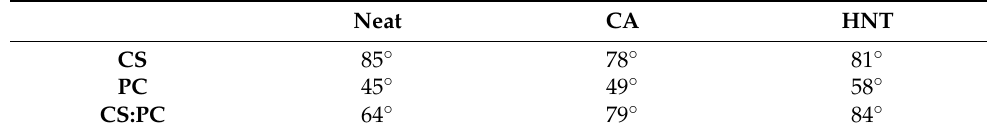
Table 1. Water contact angle (WCA) values of all investigated samples.